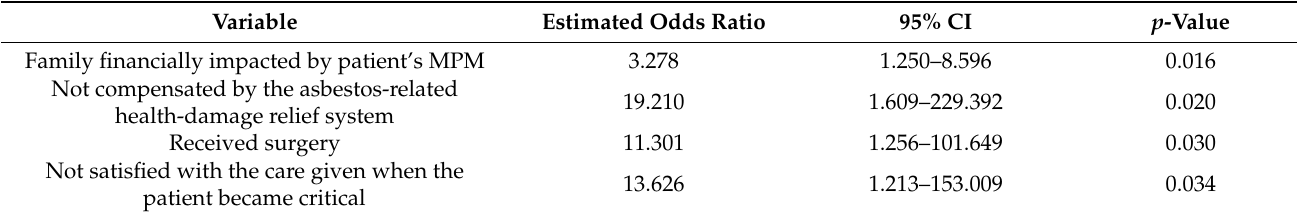
Table 3. Binominal logistic regression model predicting CG ( n =